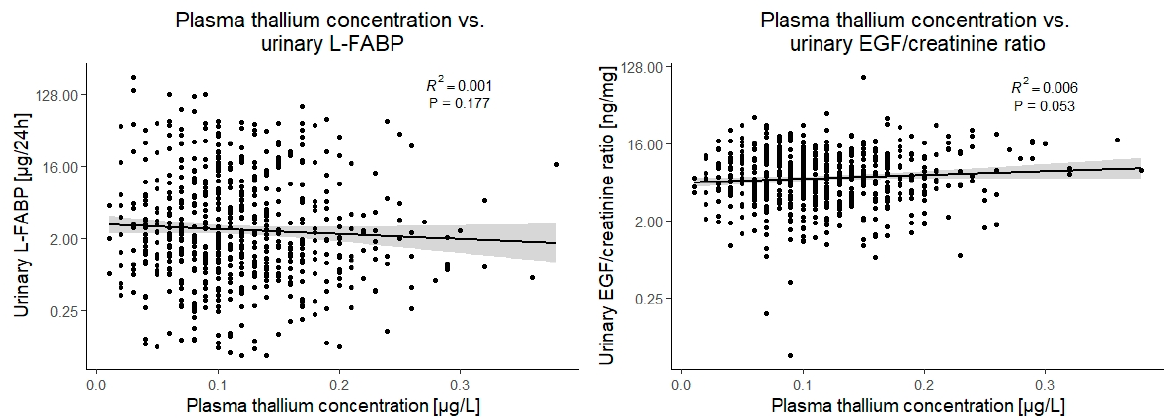
Figure 2. Scatter plots and visual presentation of the linear association of plasma thallium concen- tration with the parameters of tubular damage. EGF, endothelial growth factor; NGAL, neutrophil- gelatinase associated lipocalin; L-FABP, liver-type fatty acid-binding protein.